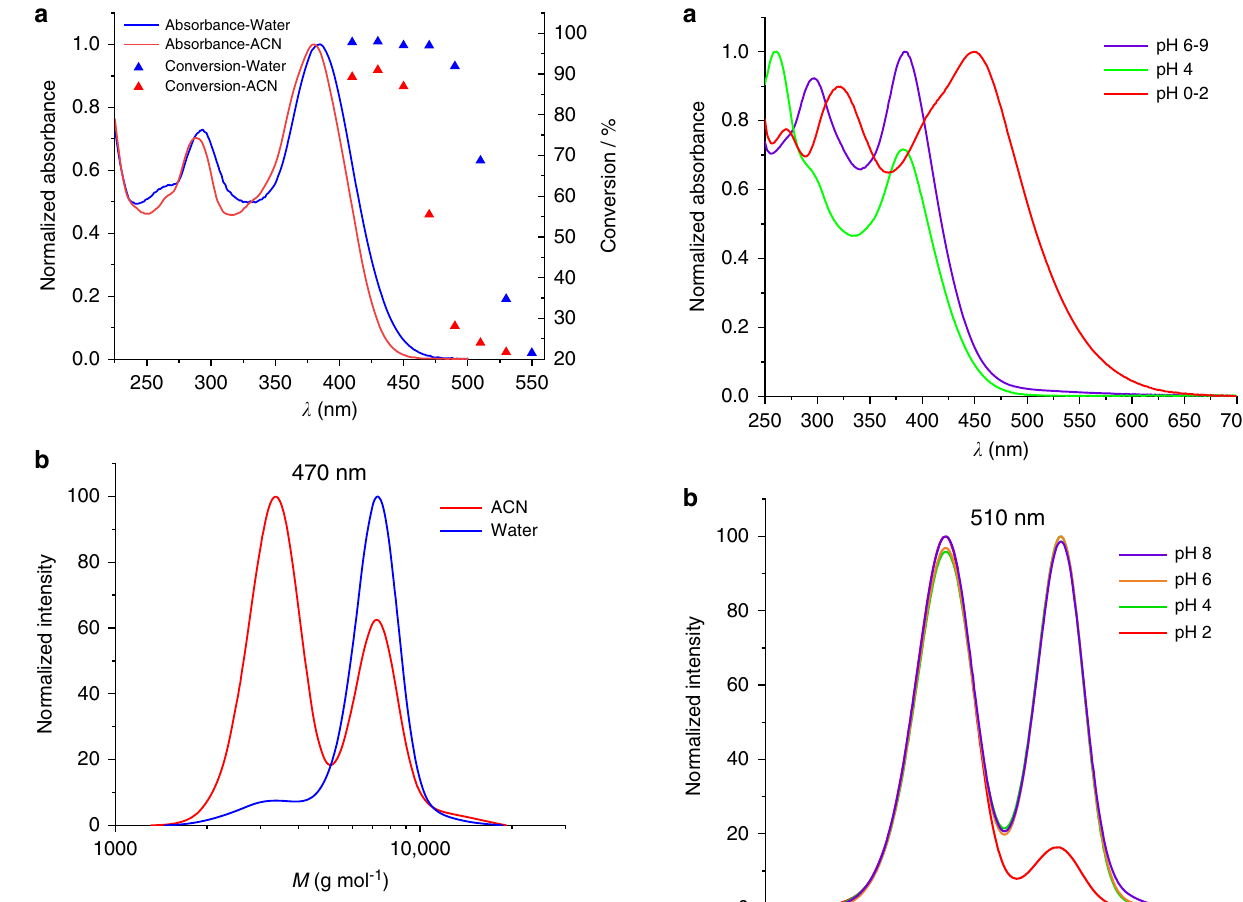
Fig. 3 Solvent dependent action plots. a Action plot and UV/vis spectra of PEG-SQ in water and acetonitrile (10 mg mL − 1 solutions irradiated with 1.23 × 10 22 photons). b SEC traces showing conversion in acetonitrile (55.5%) and water (96.9%) after irradiation at 470 nm with the same number of photons (1.23 × 10 22 ).